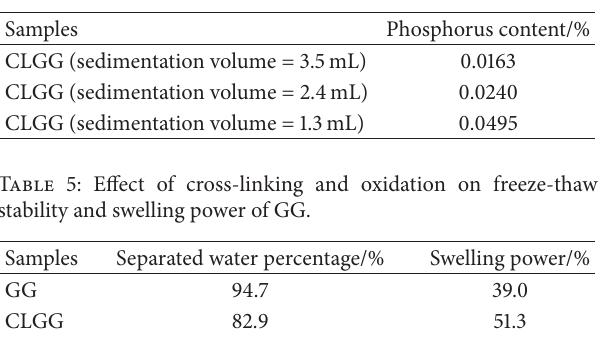
Table 4: The relationship between sedimentation volume and phosphorus content for CLGG.